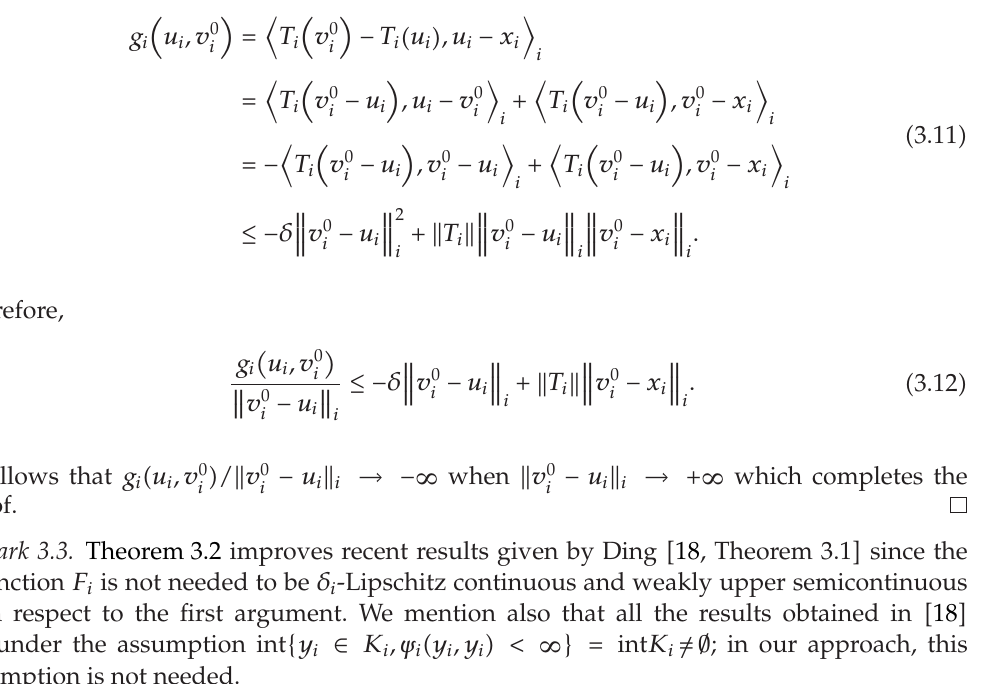
(cid:3) ∈ K , x 0 2 1